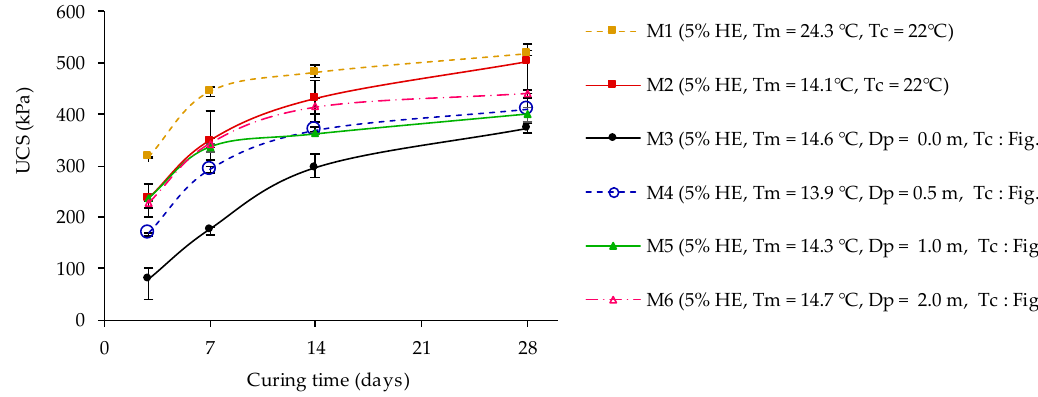
Figure 2. UCS variation with curing time for CPB containing 5% HE cured at constant temperature (22 °C) in the humidity chamber (M1 and M2) and at decreasing temperatures (M3 to M6) depending on the distance Dp from the CPB–permafrost wall interface: 0 m (M3), 0.5 m (M4), 1 m (M5), and 2 m (M6).